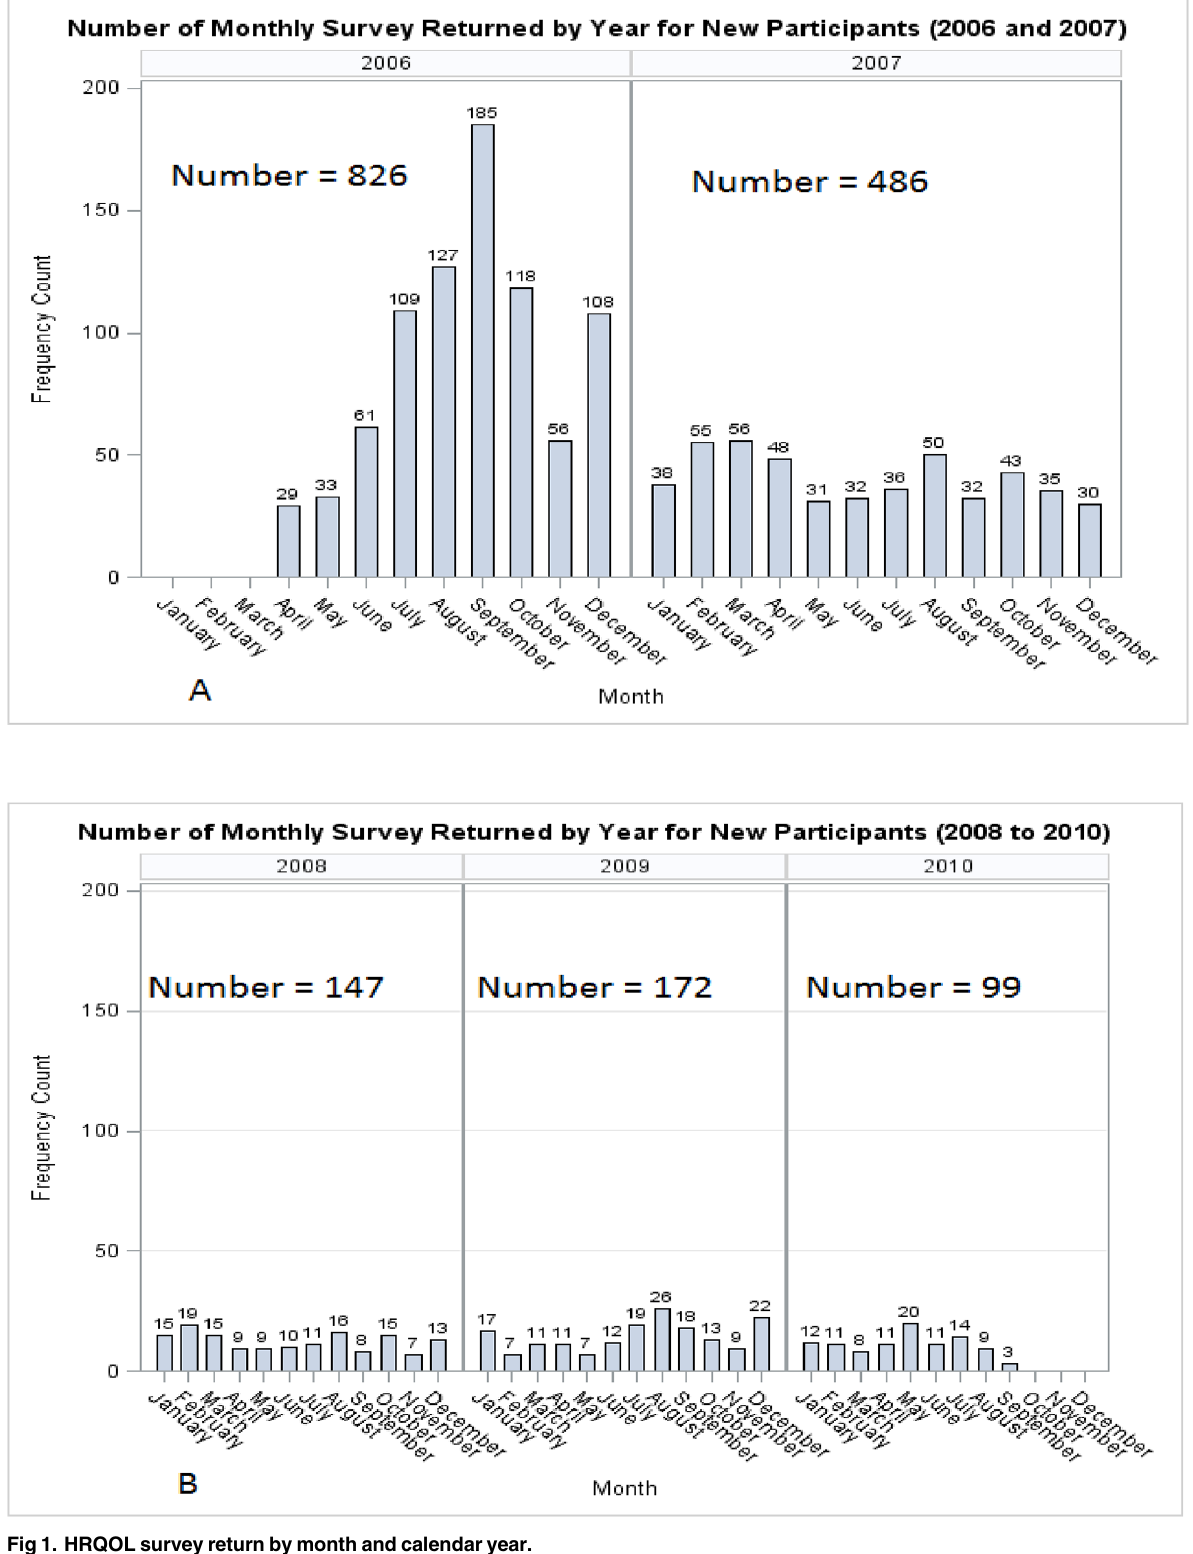
Fig 1. HRQOL survey return by month and calendar year.